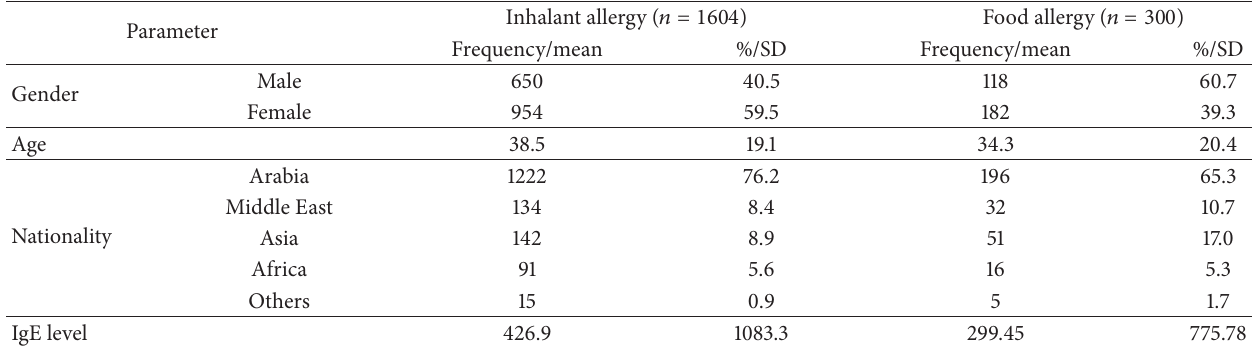
Table 1: Population characteristics.